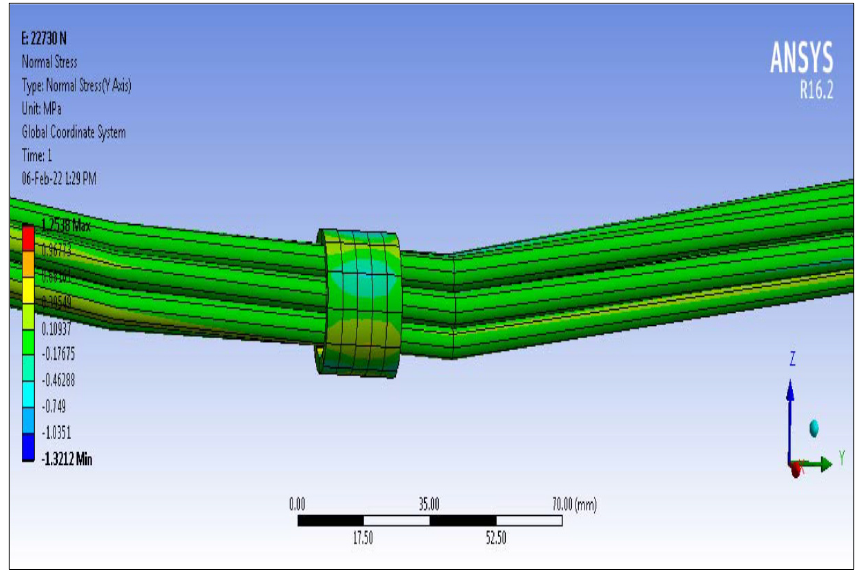
Figure 16. Phase II Normal Stress distributions on steel wire rope.